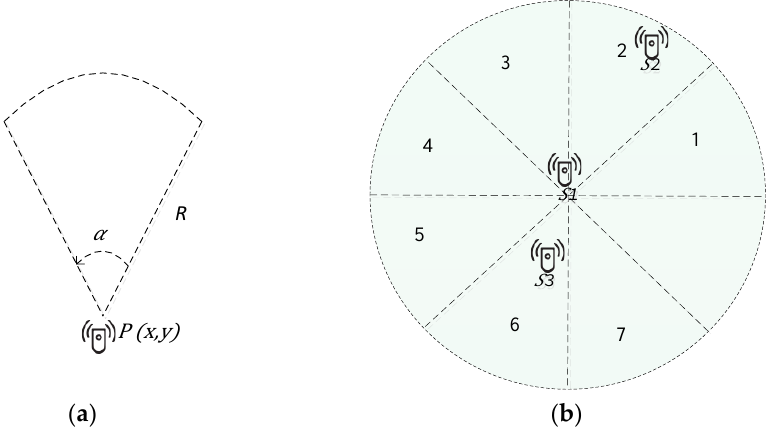
Figure 2. Smart environments, ( a ) angular sensing; ( b ) angular transmitting in in the region.